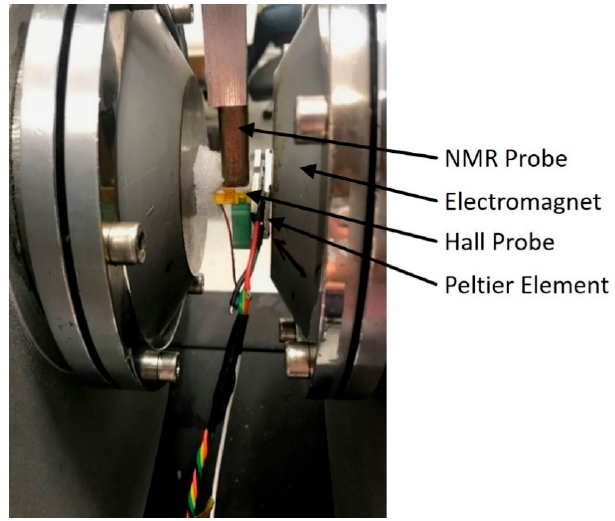
Figure 9. Electromagnet setup showing the Hall probe placed between the poles with the NMR probe on top of it. The Peltier element is placed in physical contact with the Hall probe on the right-hand